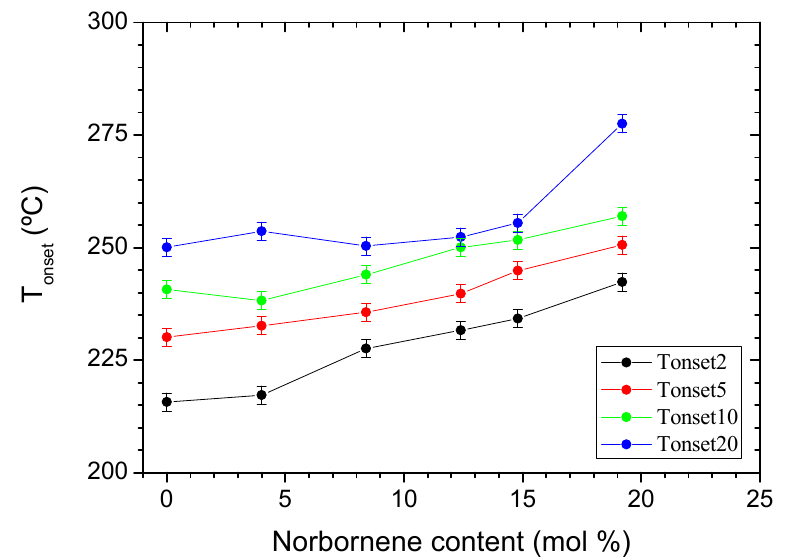
Figure 7. Onset and offset temperatures as a function of the norbornene contents (bars correspond to an error of ±2 °C).